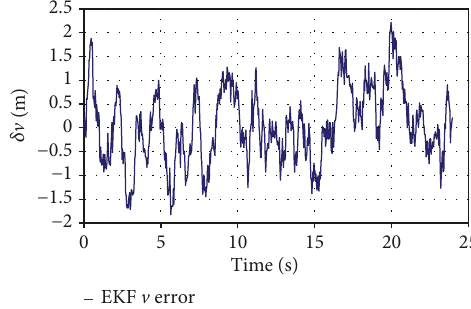
Figure 14: Error of estimation of ICP-89 velocity.